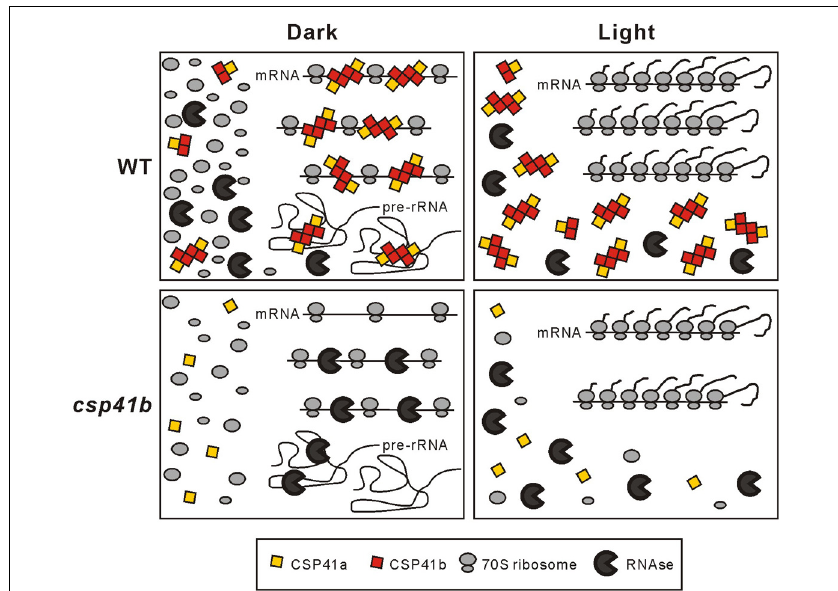
FIGURE 1 | Model for action of CSP41 protein complexes. In the dark, CSP41 protein complexes associate with various mRNAs and some pre-rRNAs and protect them from nucleolytic cleavage. Untranslated RNAs not stabilized by CSP41 protein complexes are degraded by ribonucleases. Newly synthesized precursors of rRNAs are rapidly incorporated in the light into functional ribosomes, which in turn stabilize plastid transcripts during translation. In the absence of CSP41b, protection of mRNAs and pre-rRNAs in the dark is impaired and HMW RNA-CSP41 complexes are not formed. In consequence less functional ribosomes and mRNAs are available in the light. Therefore, less photosynthetic subunits are synthesized and the translational capacity is generally decreased. The latter can explain the pleiotropic effects seen in csp41b plants. Modified from Qi et al.